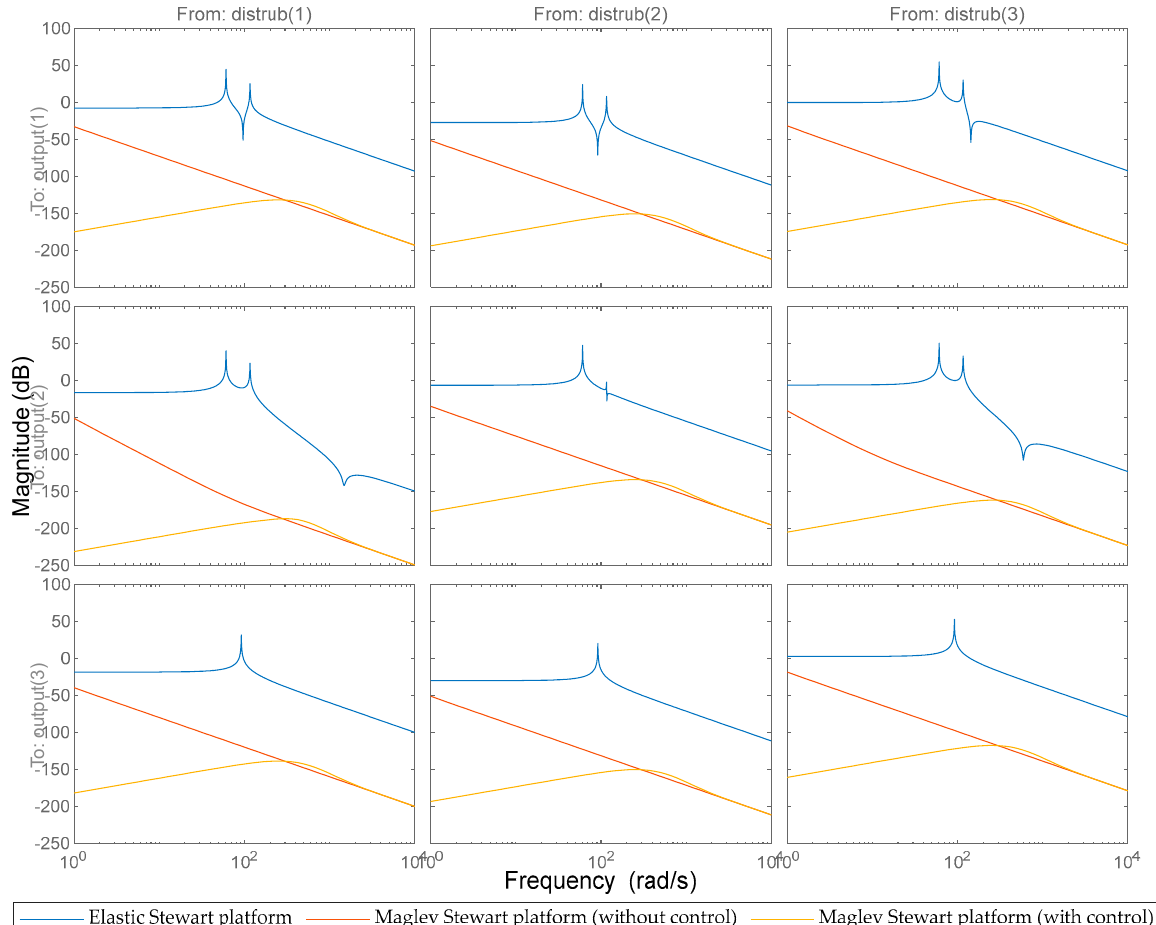
Figure 7. The frequency response from the base to the payload.